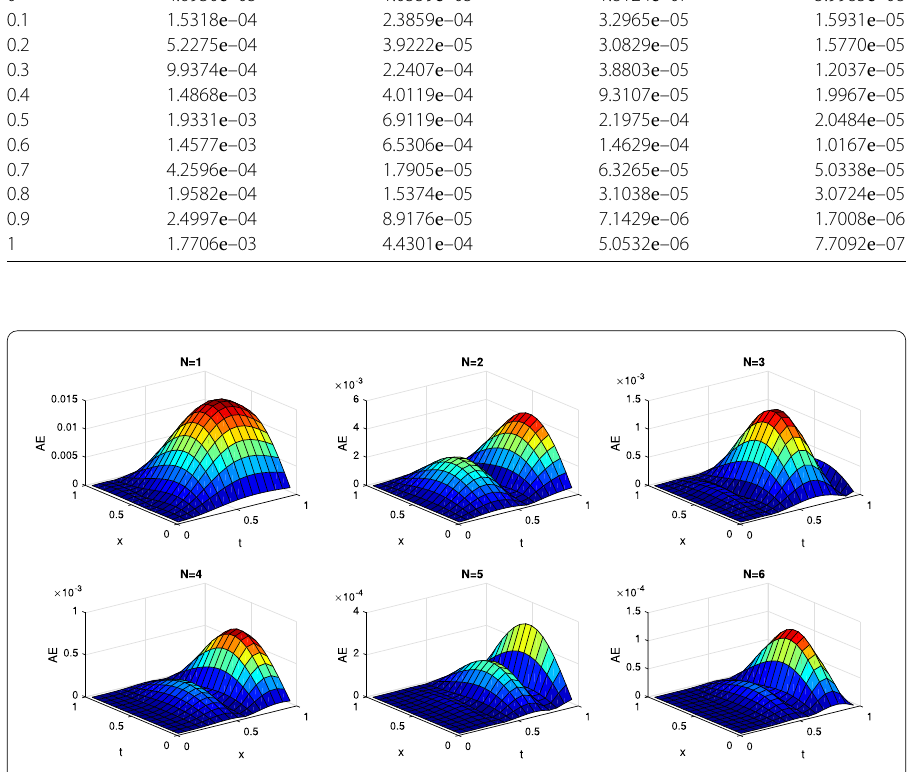
Figure 2 Absolute errors(AE) for different values of N , α = 1, k = 2, M = 8 in Example 2